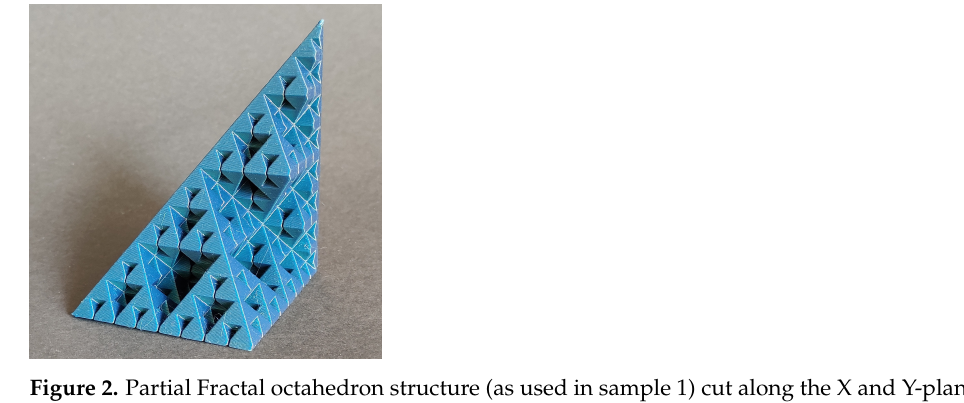
Figure 2. Partial Fractal octahedron structure (as used in sample 1) cut along the X and Y-plane for illustration purposes to highlight the complex inner structure; the shown object was manufactured via Fused Deposition Modelling.